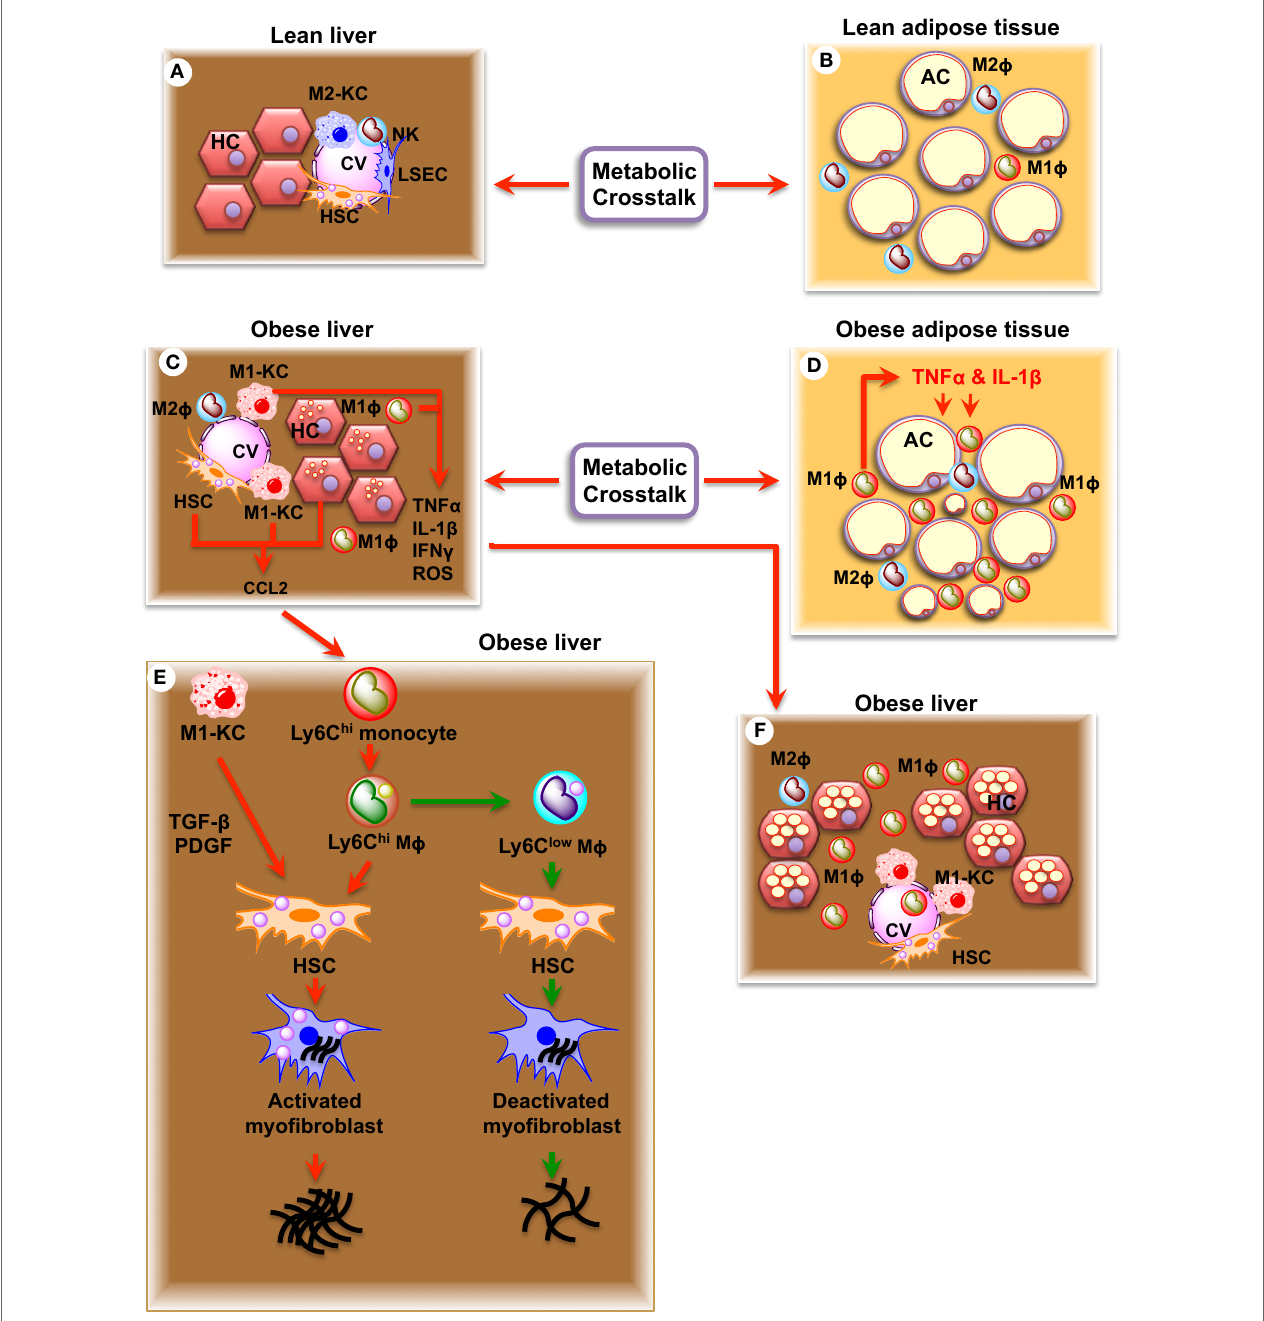
FigURe 2 | Schematic diagram showing the effects of resident (KC) and recruited hepatic macrophages (Ly6C high ) in regulation of non-alcoholic fatty liver disease (nAFLD) and fibrosis . (A) Healthy liver showing parenchymal hepatocytes (HC) and non-parenchymal Kupffer cells (M2-KC), natural killer cells (NK), hepatic stellate cells (HSC), and liver sinusoidal endothelial cells (LSEC). (B) Healthy adipose tissue showing adipocytes (AC), adipocyte macrophage 1 (ATM1), and ATM2 macrophages. (C) Obese liver showing accumulation of lipid droplets in hepatocytes (HC), activated Kupffer cells (M1-KC), and activated hepatic stellate cells (HSC). Note increased production of TNF- α , IL-1 β , IFN γ , ROS, and CCL2. (D) Obese adipose tissue showing larger adipocytes (AC), infiltrated ATM1 macrophages, and increased production of TNF- α and IL-1 β . (e) Obese liver showing NAFLD and NASH. (F) Obese liver showing fibrosis. Increased production of CCL2 recruits Ly6C high monocytes, which convert to Ly6C high macrophages inside the liver. Ly6C high macrophages produce TGF β , connective tissue growth factor (CTGF), and PDGF, which act on HSC and transform HSC to activated myofibroblast. Activated myofibroblast in turn results in fibrosis. Ly6C high macrophage is transformed into Ly6C low macrophage upon eating dead hepatocytes and erythrocytes. Ly6C low macrophage deactivates activated myofibroblasts and decrease